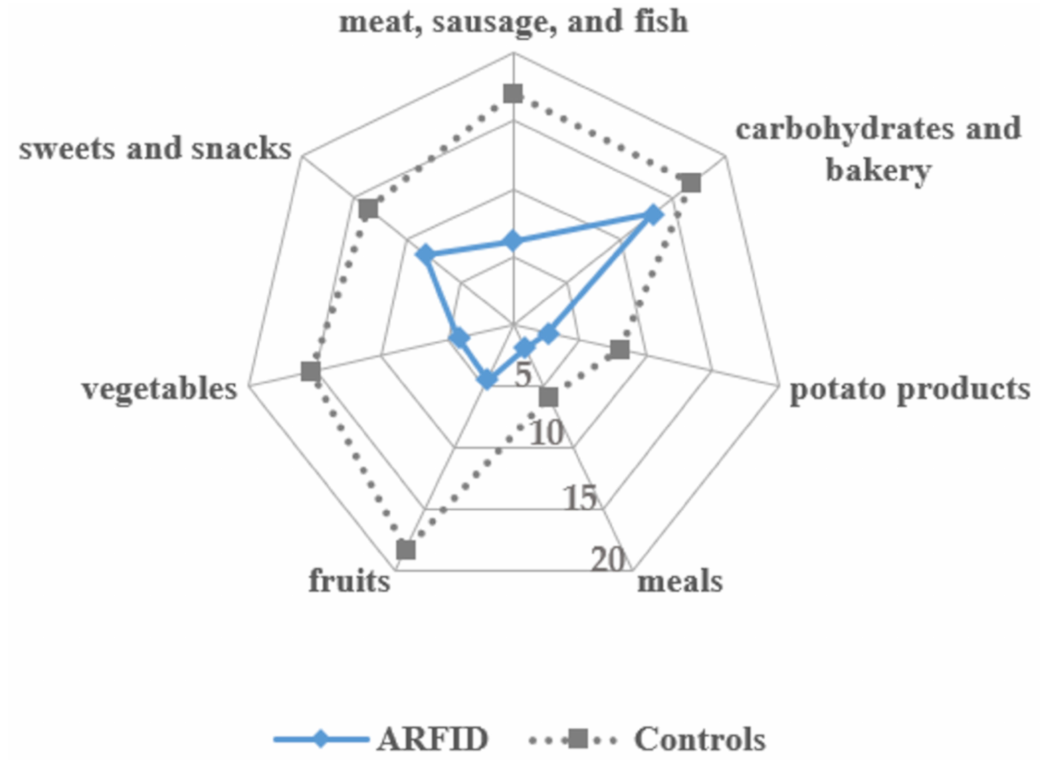
Figure 1. Variety of food intake in avoidant/restrictive food intake disorder (ARFID) and individually matched controls depicting the number of accepted foods per food